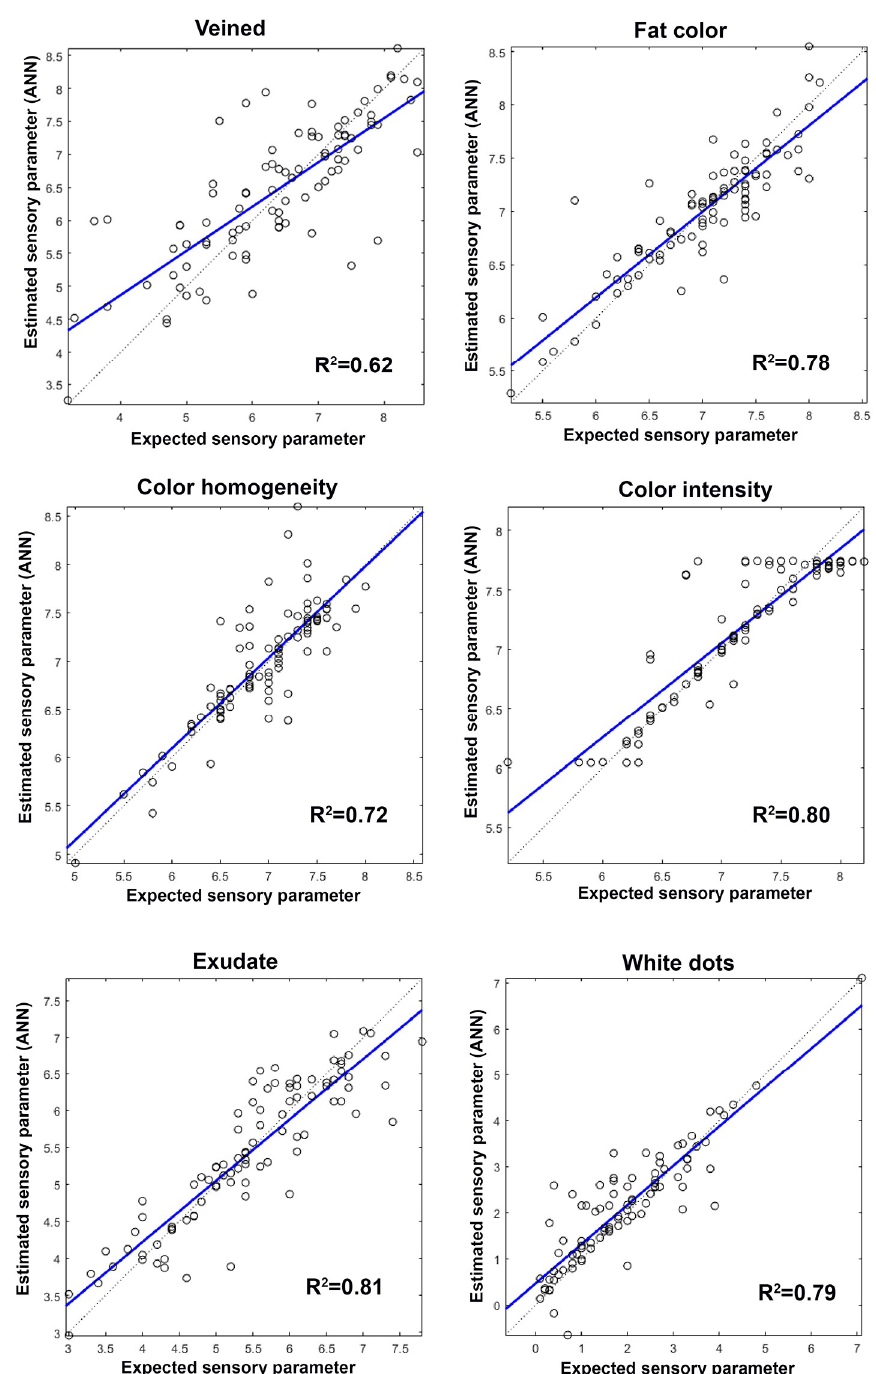
Figure 3. Comparison of the reference values (target) with the values predicted by ANNs for visual parameters and R